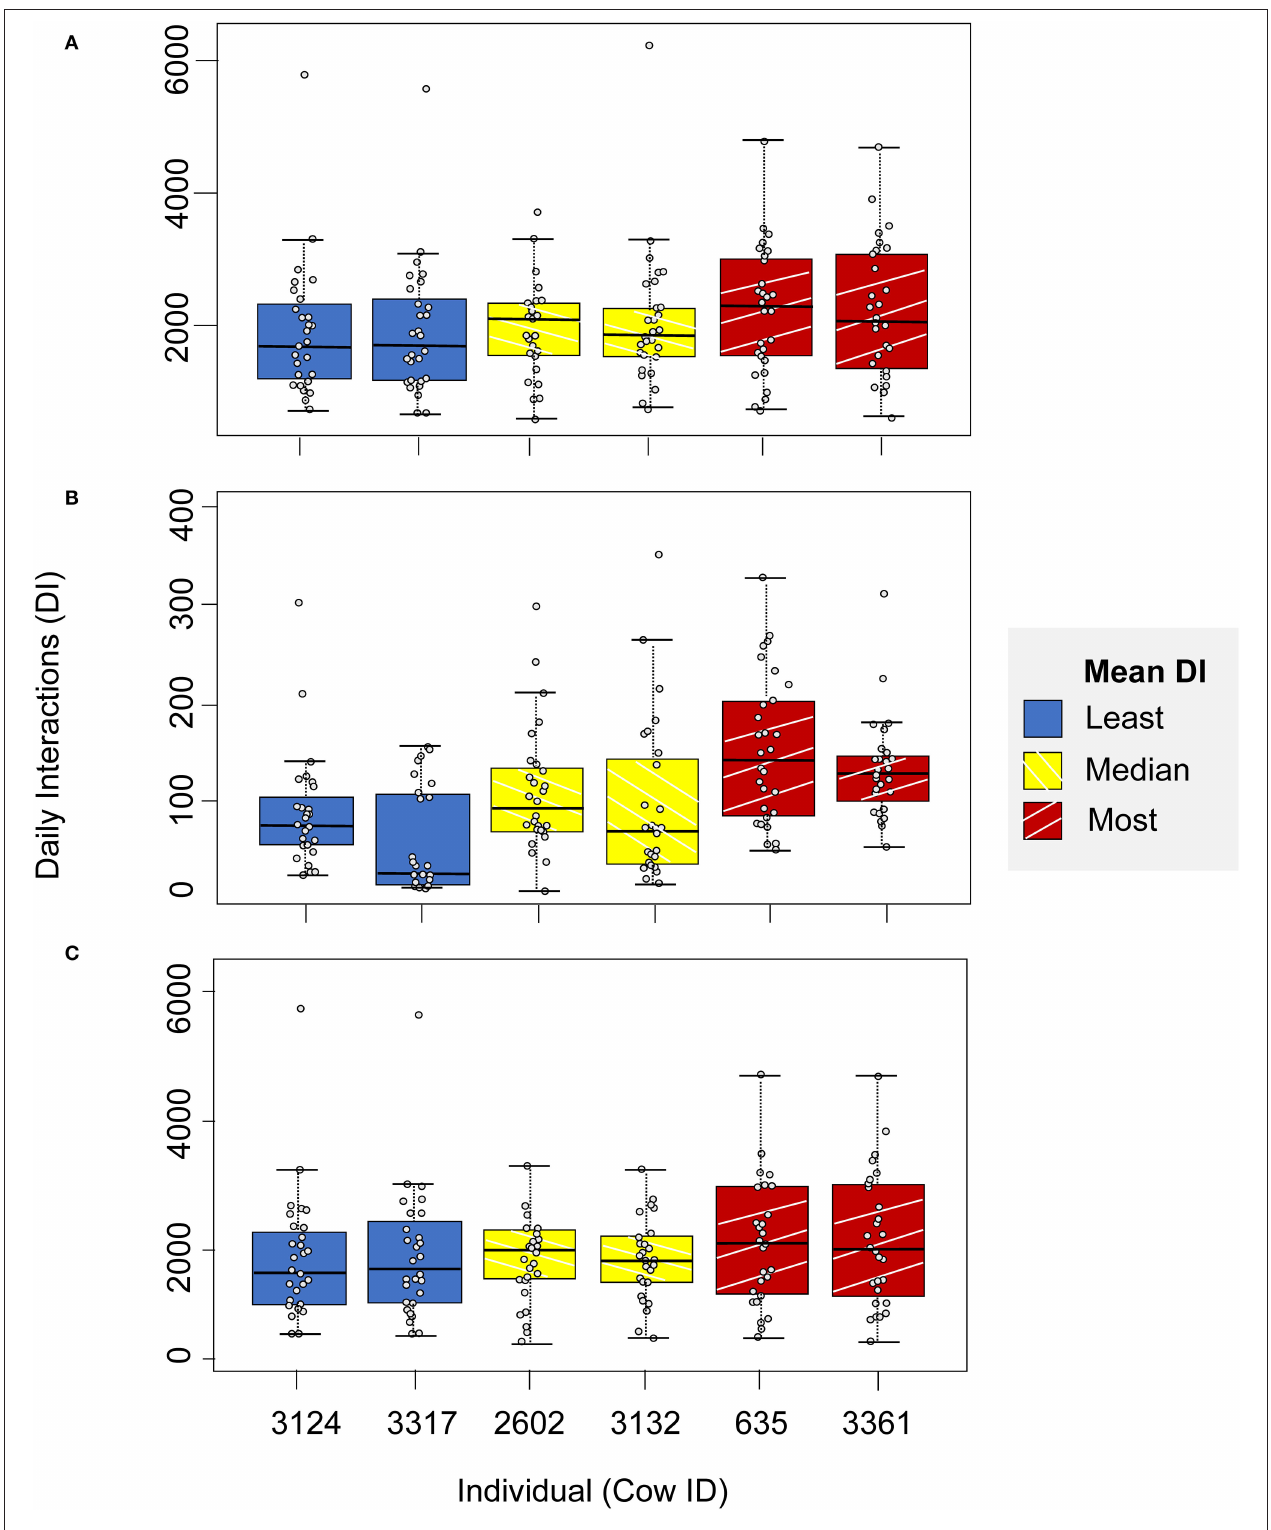
FIGURE 3 | Daily interactions in (A) the full barn, (B) feeding zone, and (C) non-feeding zone, for a highlighted illustrative subset of individuals: two individuals with the least mean daily interactions (blue, cow ID = 3124 and 3317), two with mean daily interactions closest to the median value (yellow, cow ID = 2602 and 3132) and two with the highest mean daily interactions (red, cow ID = 635 and